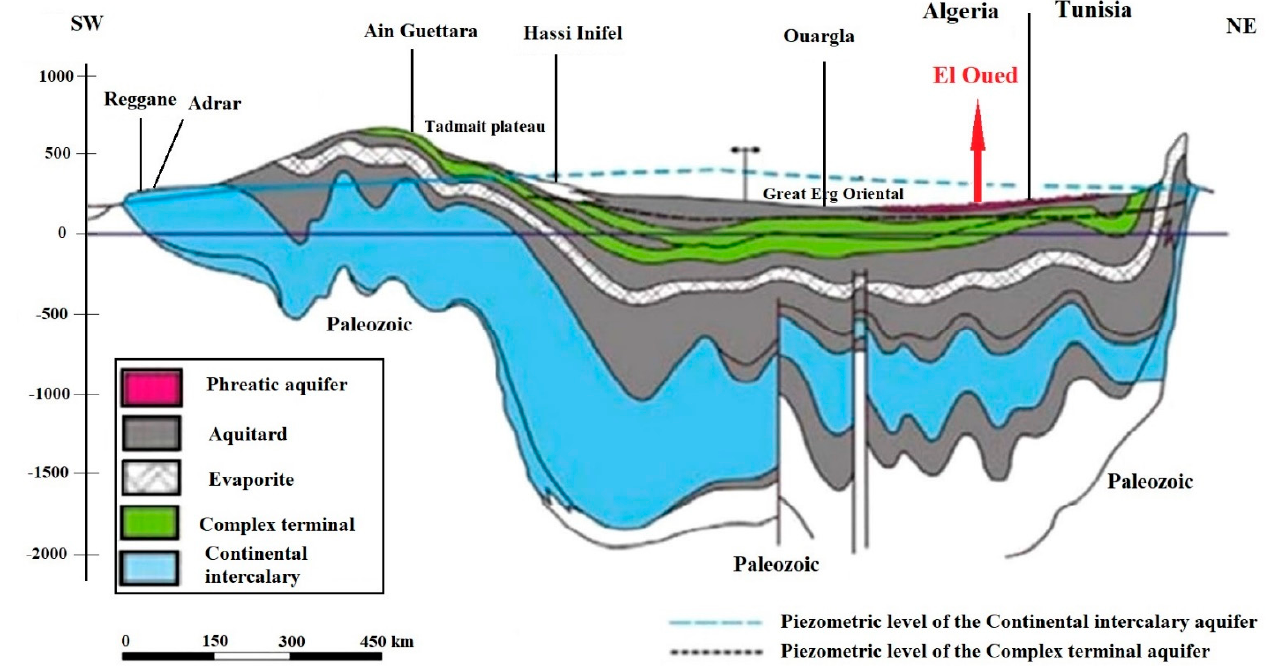
Figure 3. The three aquifers are shown in a hydrogeological section that passes through the study area modified from [78].